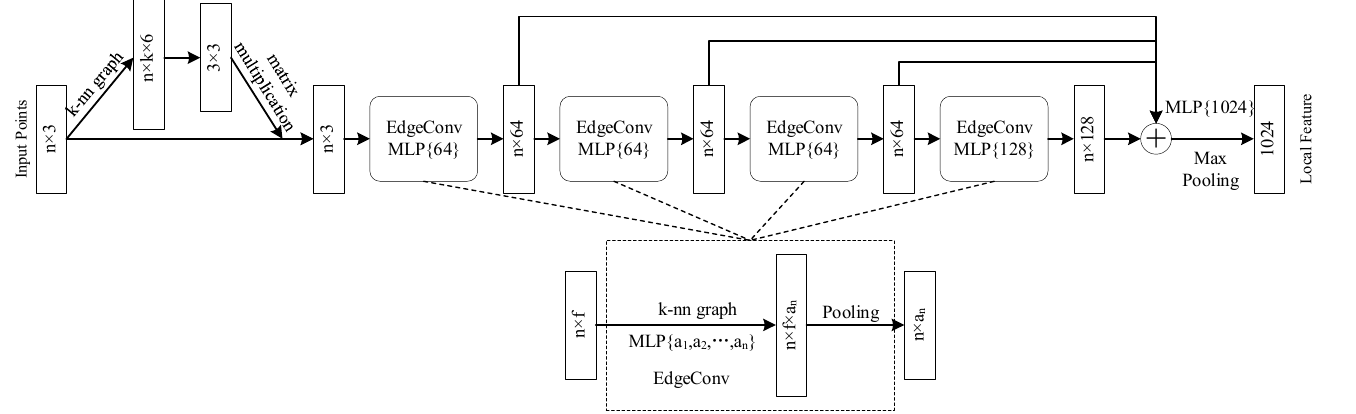
Figure 4. Architecture of local feature extraction network.